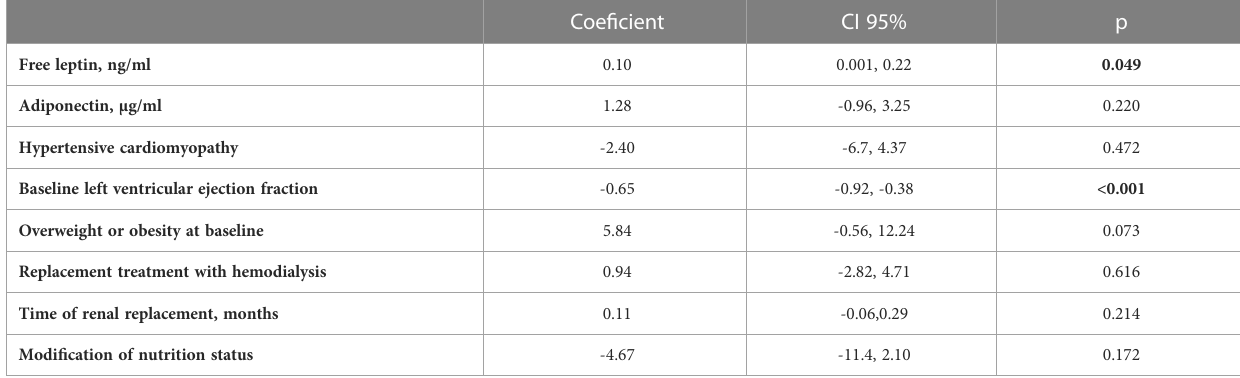
TABLE 3A Linear regression analysis to identify the association of free leptin with delta-left ventricular ejection fraction at 24-month follow-up in CPK pediatric patients (n=56).